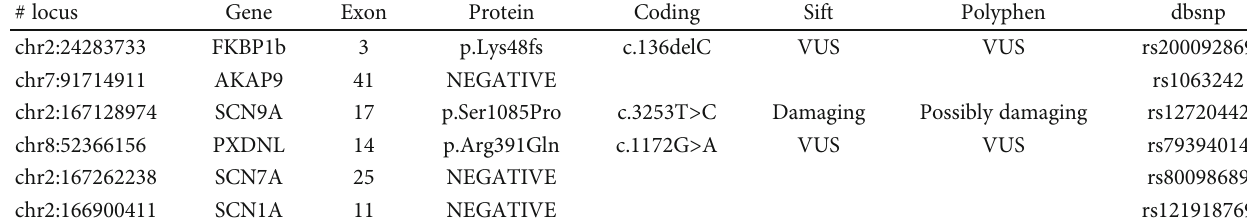
Table 1: MMRL1126 87 gene panel results.